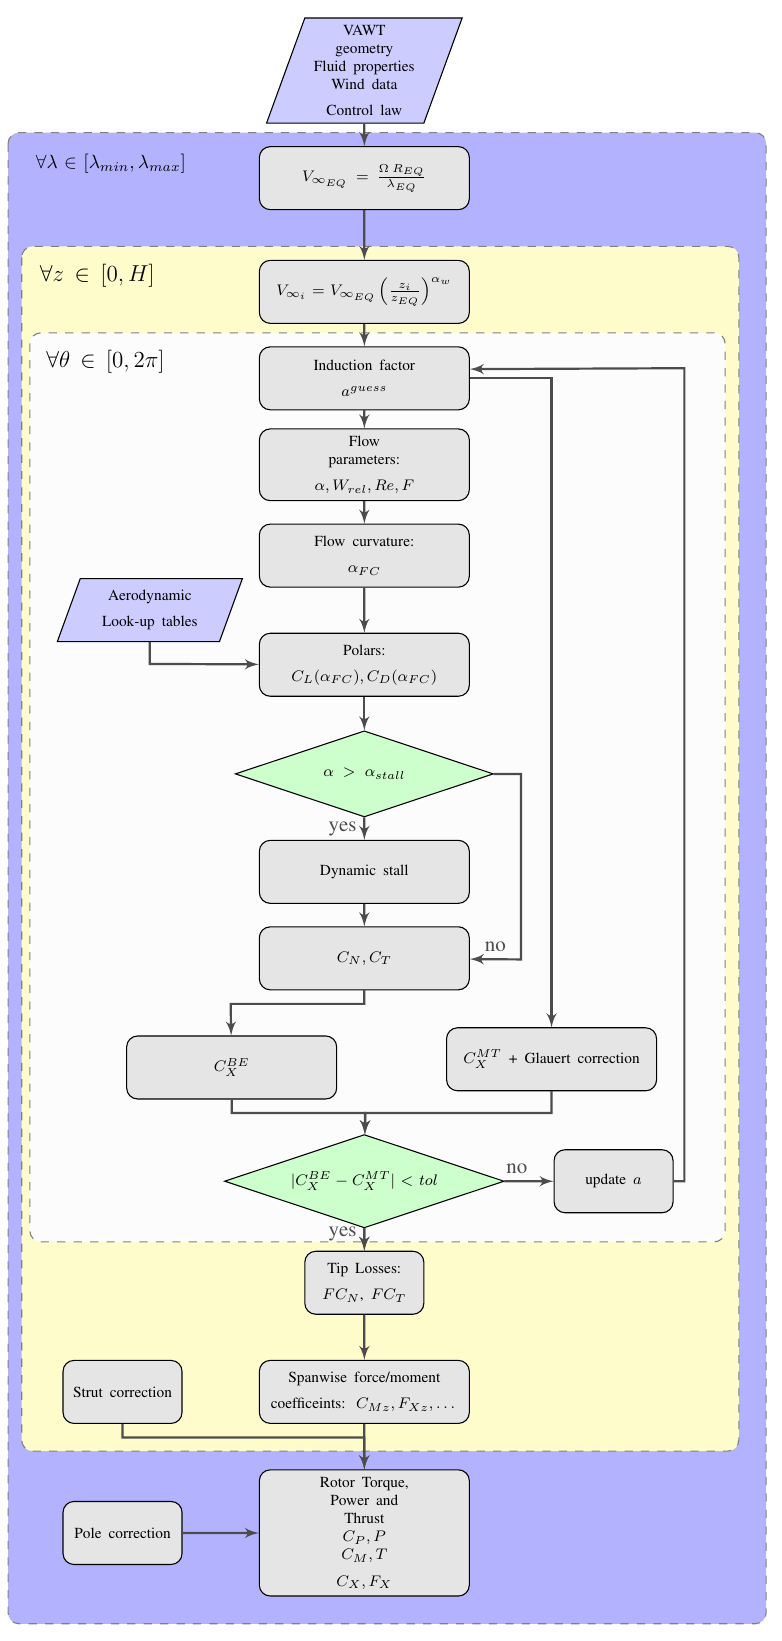
Figure 3. Flow chart with the DMST algorithm implemented in 3D BEM